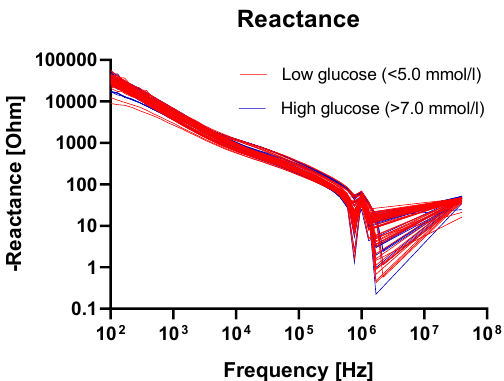
Fig.3: Measured reactance as a function of frequency for glucose levels below 5.0 mM (blue lines) or above 7.0 mM (red